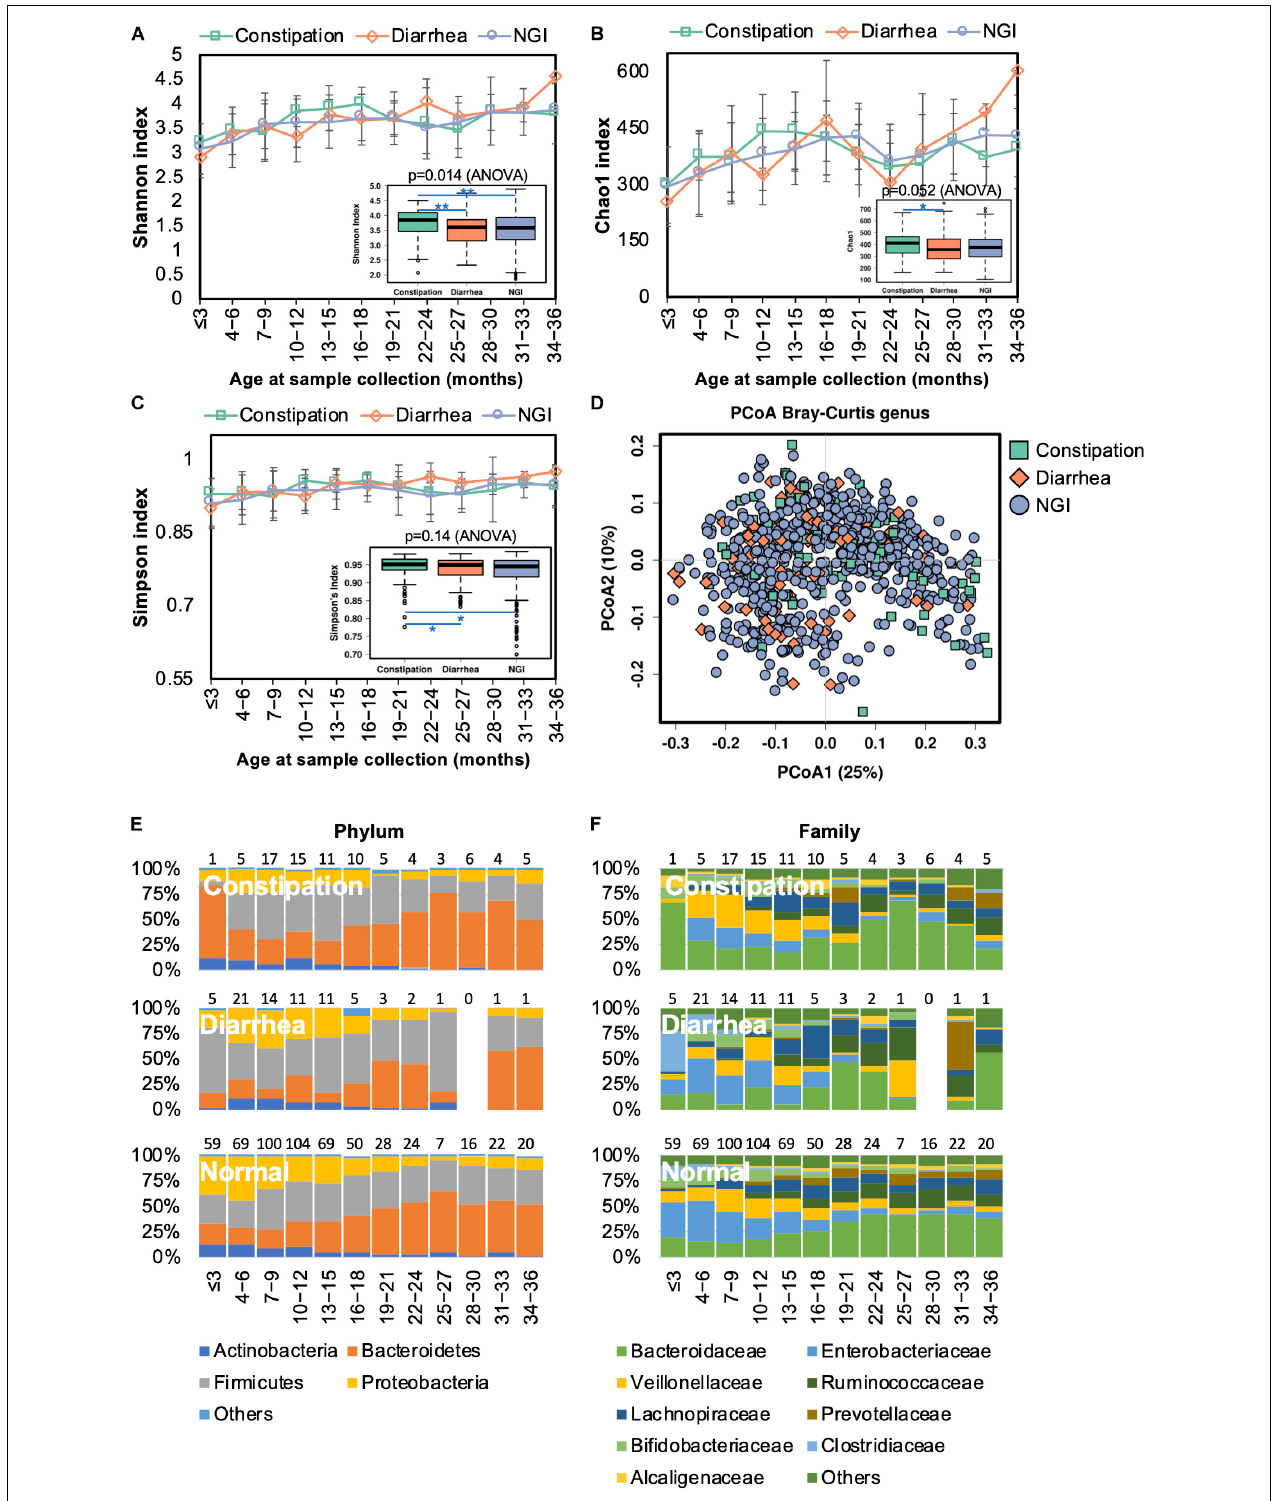
FIGURE 7 | Fecal microbiota diversity and composition for 729 children according to gastrointestinal symptoms. Alpha diversity, which was calculated with (A) Shannon index, (B) Chao1, and (C) Simpson’s index, was found to be higher in children with constipation. (D) PCoA showed no clear separation among samples from children with and without GI symptoms. Gut bacterial microbiota composition at the (E) phylum and (F) family levels. Number of children per age group is provided above bars.